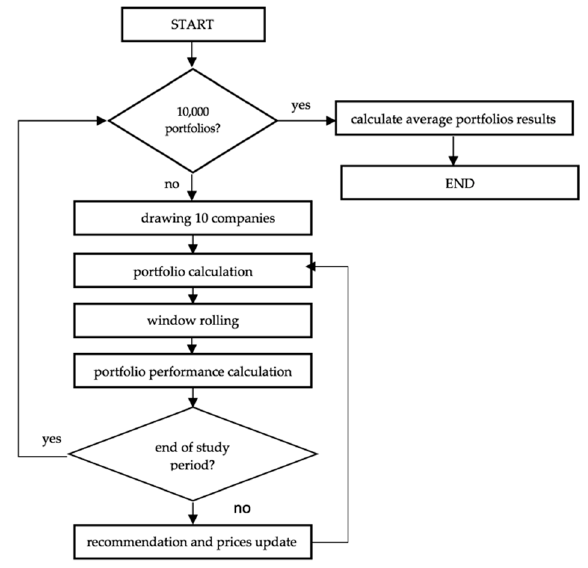
Figure 2. The procedure of empirical study.